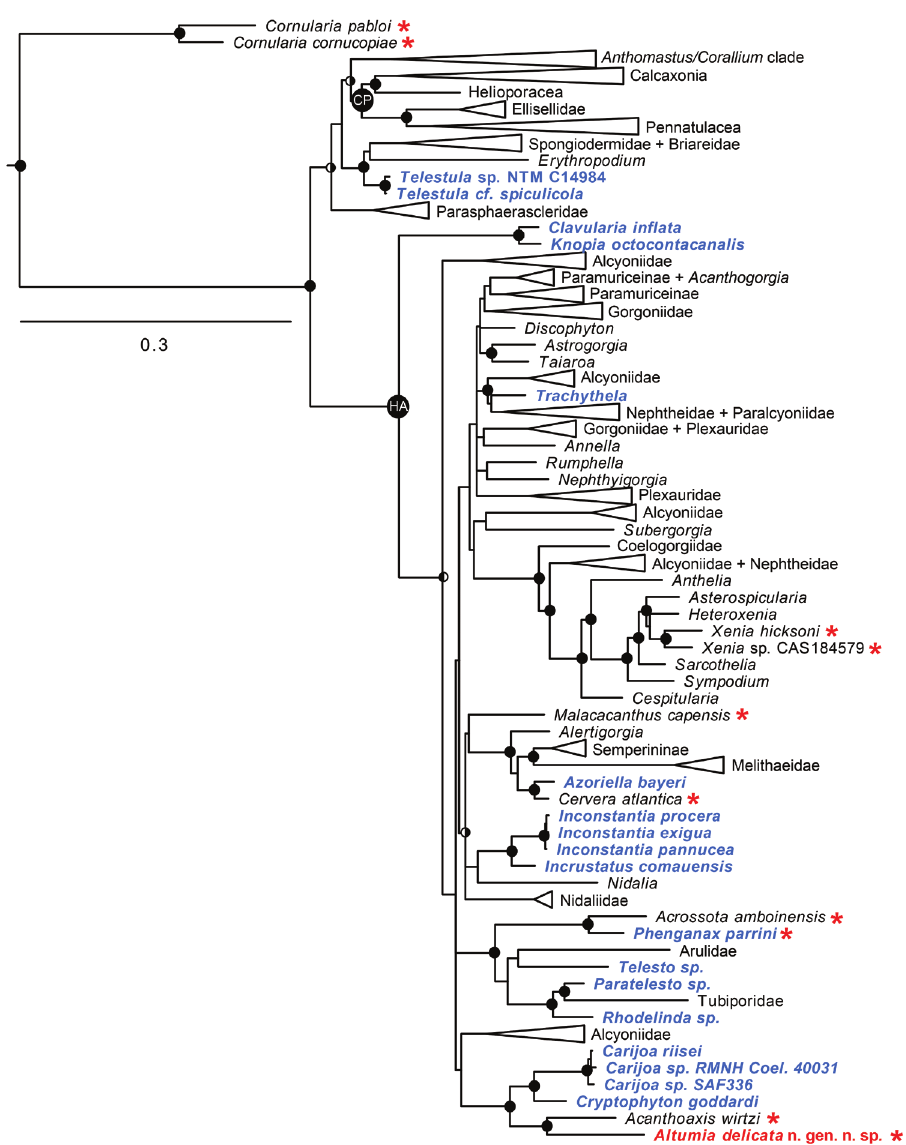
Figure 1. Phylogenetic relationships among species of octocorals that lack sclerites (red asterisks) and members of family Clavulariidae (blue labels), including Altumia delicata gen n. sp. n. (red label). Solid circles at nodes indicate strong support from both maximum-likelihood (bootstrap value >70%) and Bayesian (posterior probability >0.90) analyses; split circles indicate strong support from one analysis only (left half solid: supported by ML; right half solid: supported by Bayesian analysis). Strongly supported clades that include no clavulariid or sclerite-free species have been collapsed. Hexacorallian outgroup taxa used to root tree are not shown. For a comprehensive list of taxa and sequences included in the analyses see McFadden and Ofwegen